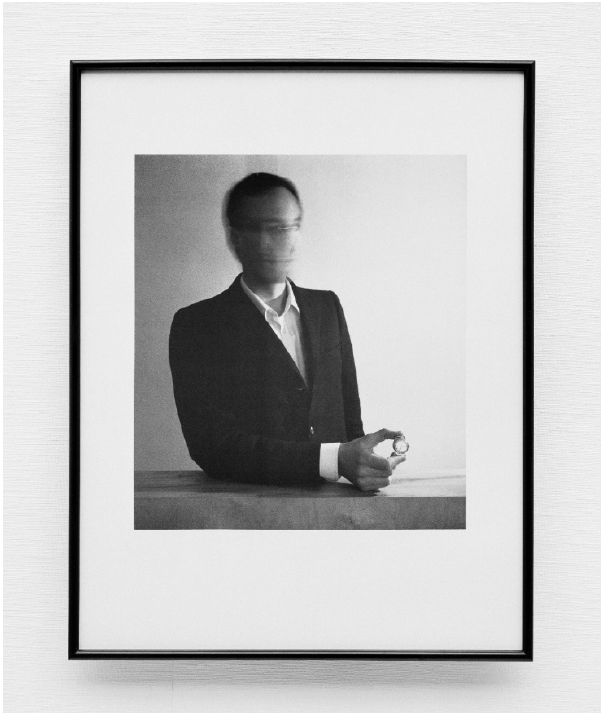
Figure 10. Jan Vercruysse, Zelfportret , 1981. Photolithoprint on paper, 69 × 53 cm, famed. Photo: Philippe Degobert. © Jan Vercruysse Foundation. Reprinted with permission from Jan Vercruysse